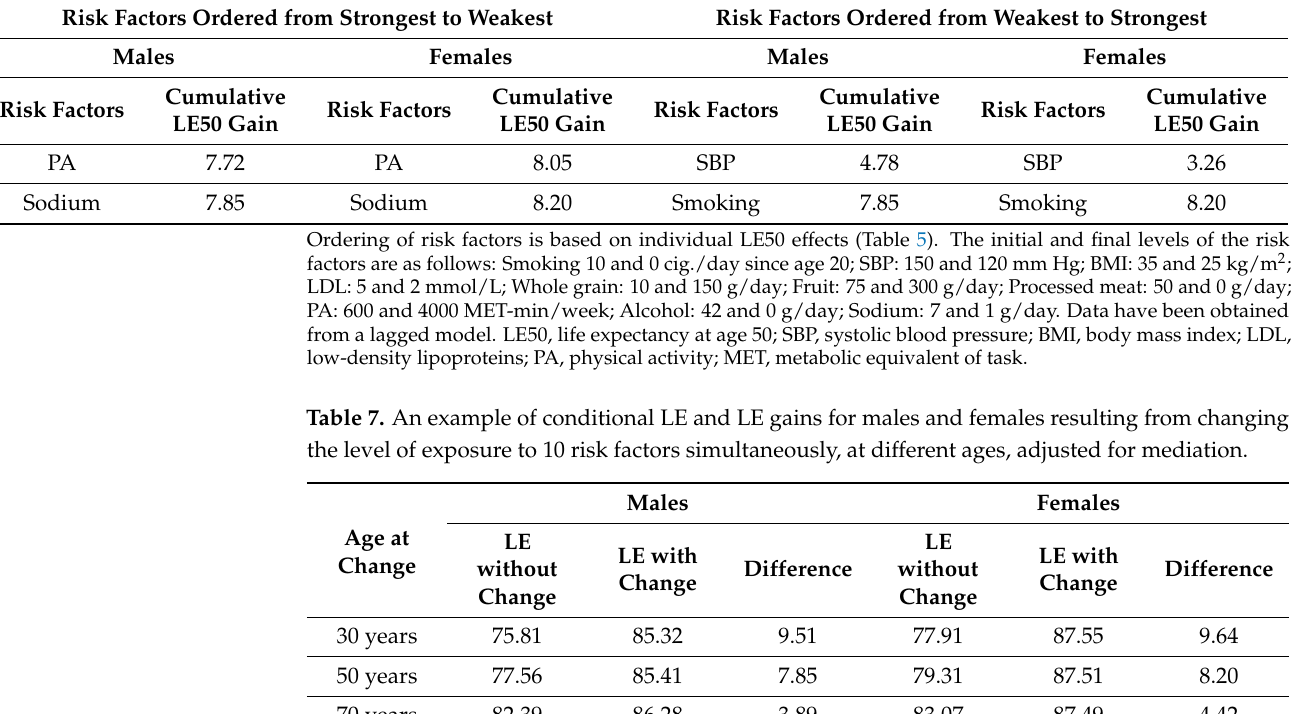
Table 6. Cont. Risk Factors Ordered from Strongest to Weakest Risk Factors Ordered from Weakest to Strongest Females Males